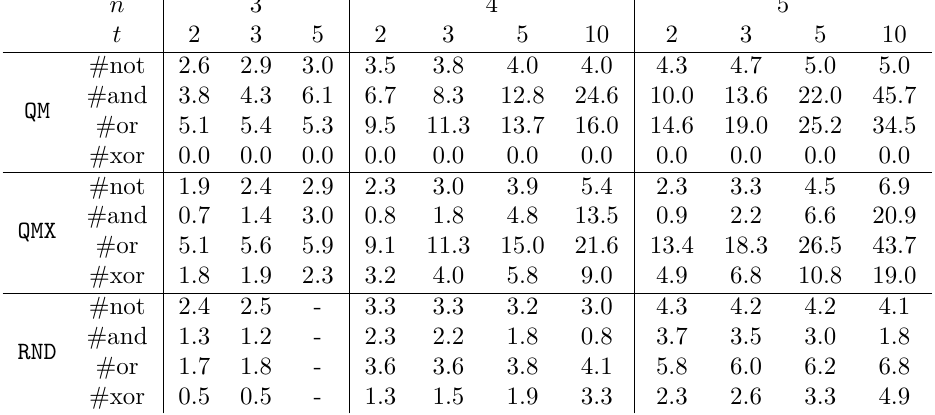
Table 1: Comparison of additional gates required for the interconnections of state register